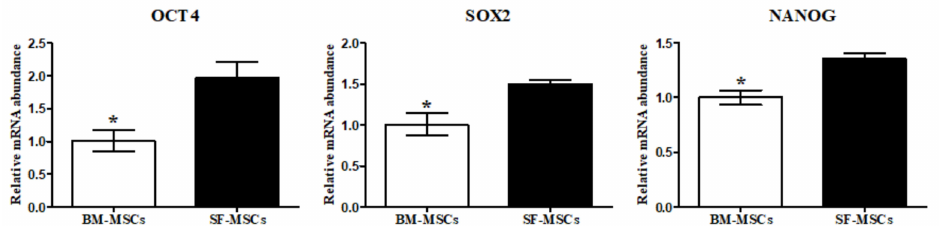
Figure 3. Stem cell transcription factor expression of BM- and SF-MSCs. SF-MSCs when related to BM-MSCs exhibited increased expression for all three transcription factors. * denote significant differences ( p < 0.05). Bar graphs illustrate mean values +/ − SD ( n =